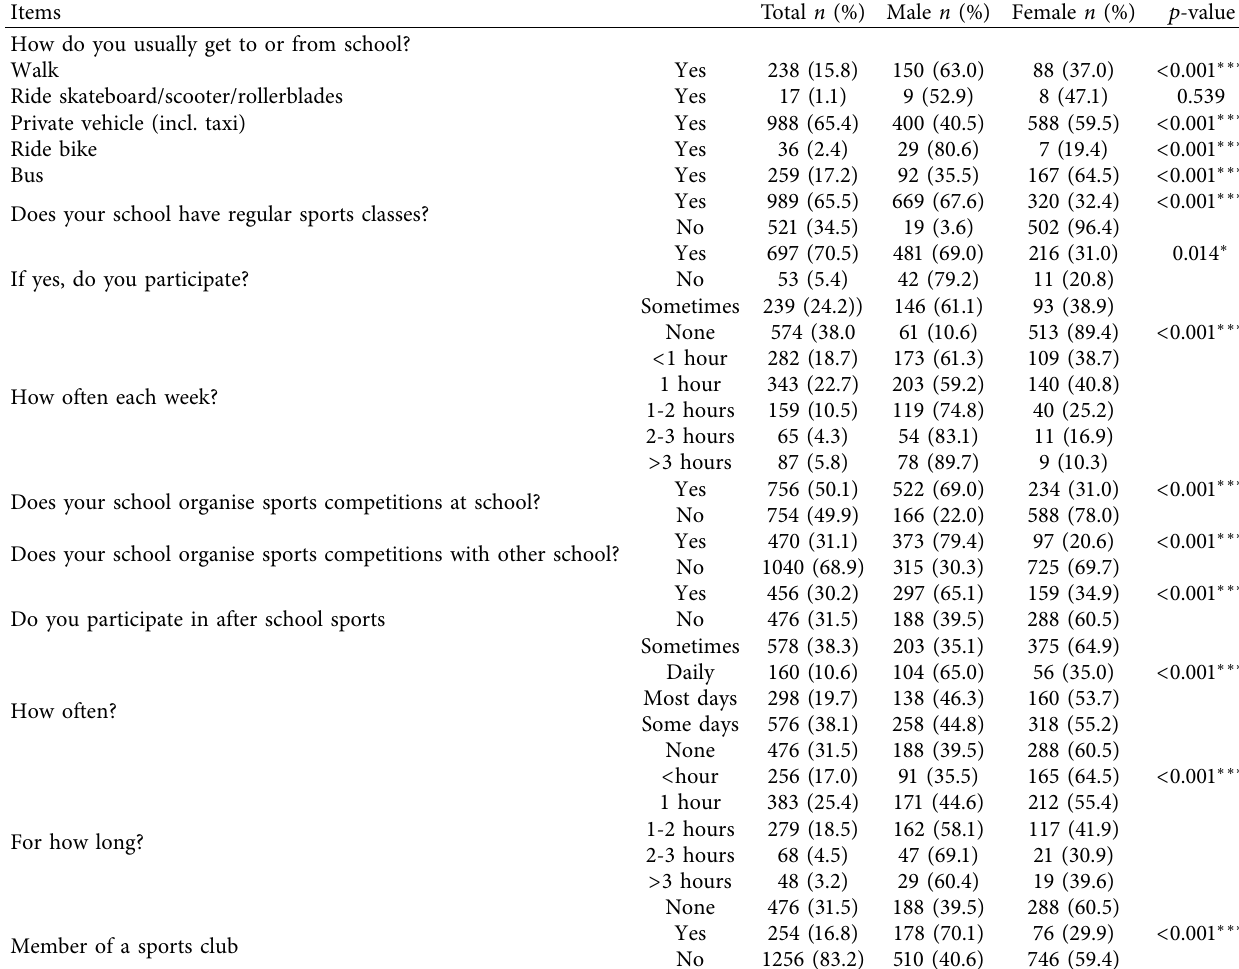
Table 3: Physical activity behaviour among students (pre-COVID-19 restrictions) among 1500 adolescents in the KSA.